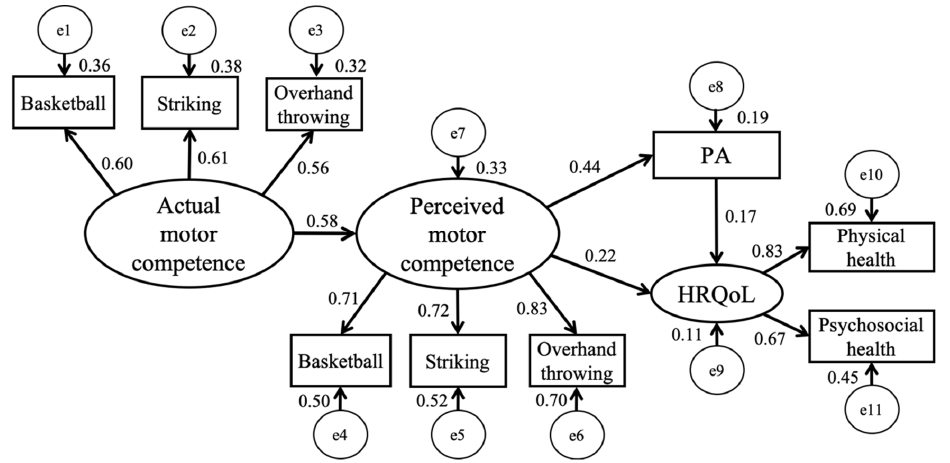
Figure 2. Final structural equation model of this study. PA = physical activity, HRQoL = health-related quality of life.